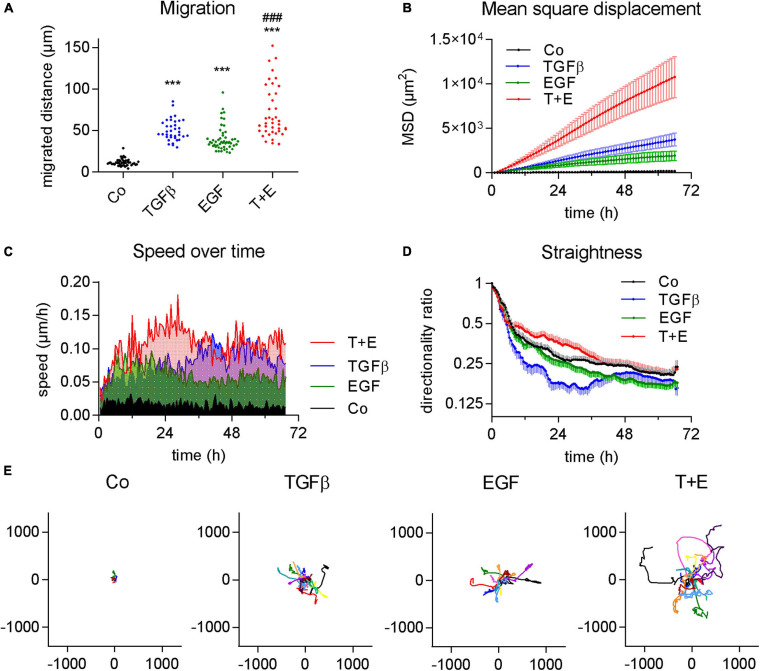
TGFβ and EGF stimulate cell migration alone and in combination. Cells were treated with TGFβ (5 ng/mL), EGF (50 ng/mL) or a combination of both (T + E), and live cell videomicroscopy was performed over 72 h with pictures taken every 5 min. This experiment was performed at least five times with two to four technical replicates. (A) Dots represent cumulative migrated distance of individual cells (36 < n < 51) over 72 h, assessed by manual single cell tracking using Image J. ***P < 0.001 treatment versus control, ###P < 0.001 T + E versus EGF, and T + E versus TGFβ, One-way ANOVA with Sidak’s multiple comparisons test. (B) Mean squared displacement (MSD), (C) average speed, (D) directionality ratio, and (E) origin plots of representative tracked cells were calculated by DiPer. Lines represent means and SD in (B,D), means only in (C), and individual cells in (E).